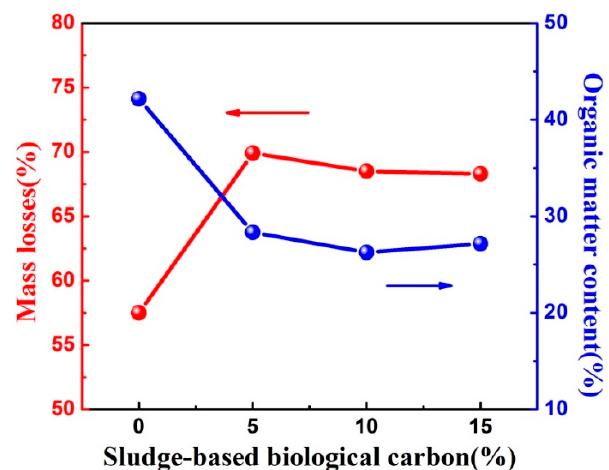
Figure 4 . Effect of the sludge-based microwave absorber on mass losses and extraction of organic matter.